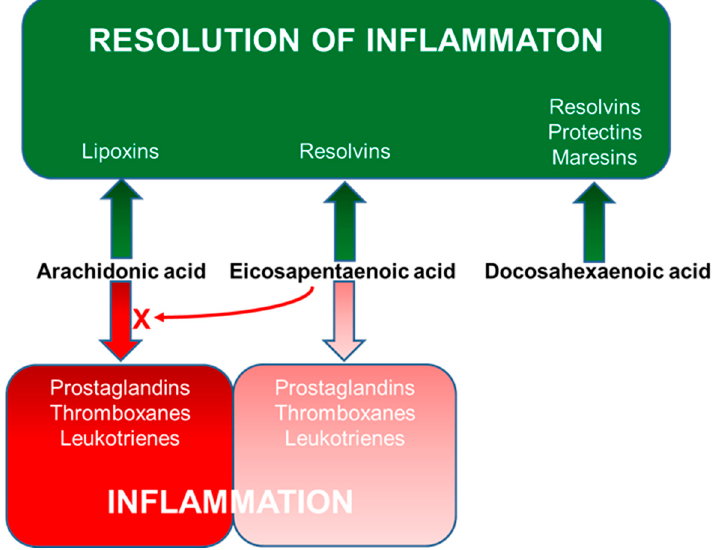
Figure 5. Overview of bioactive lipid mediator synthesis from LCPUFAs.